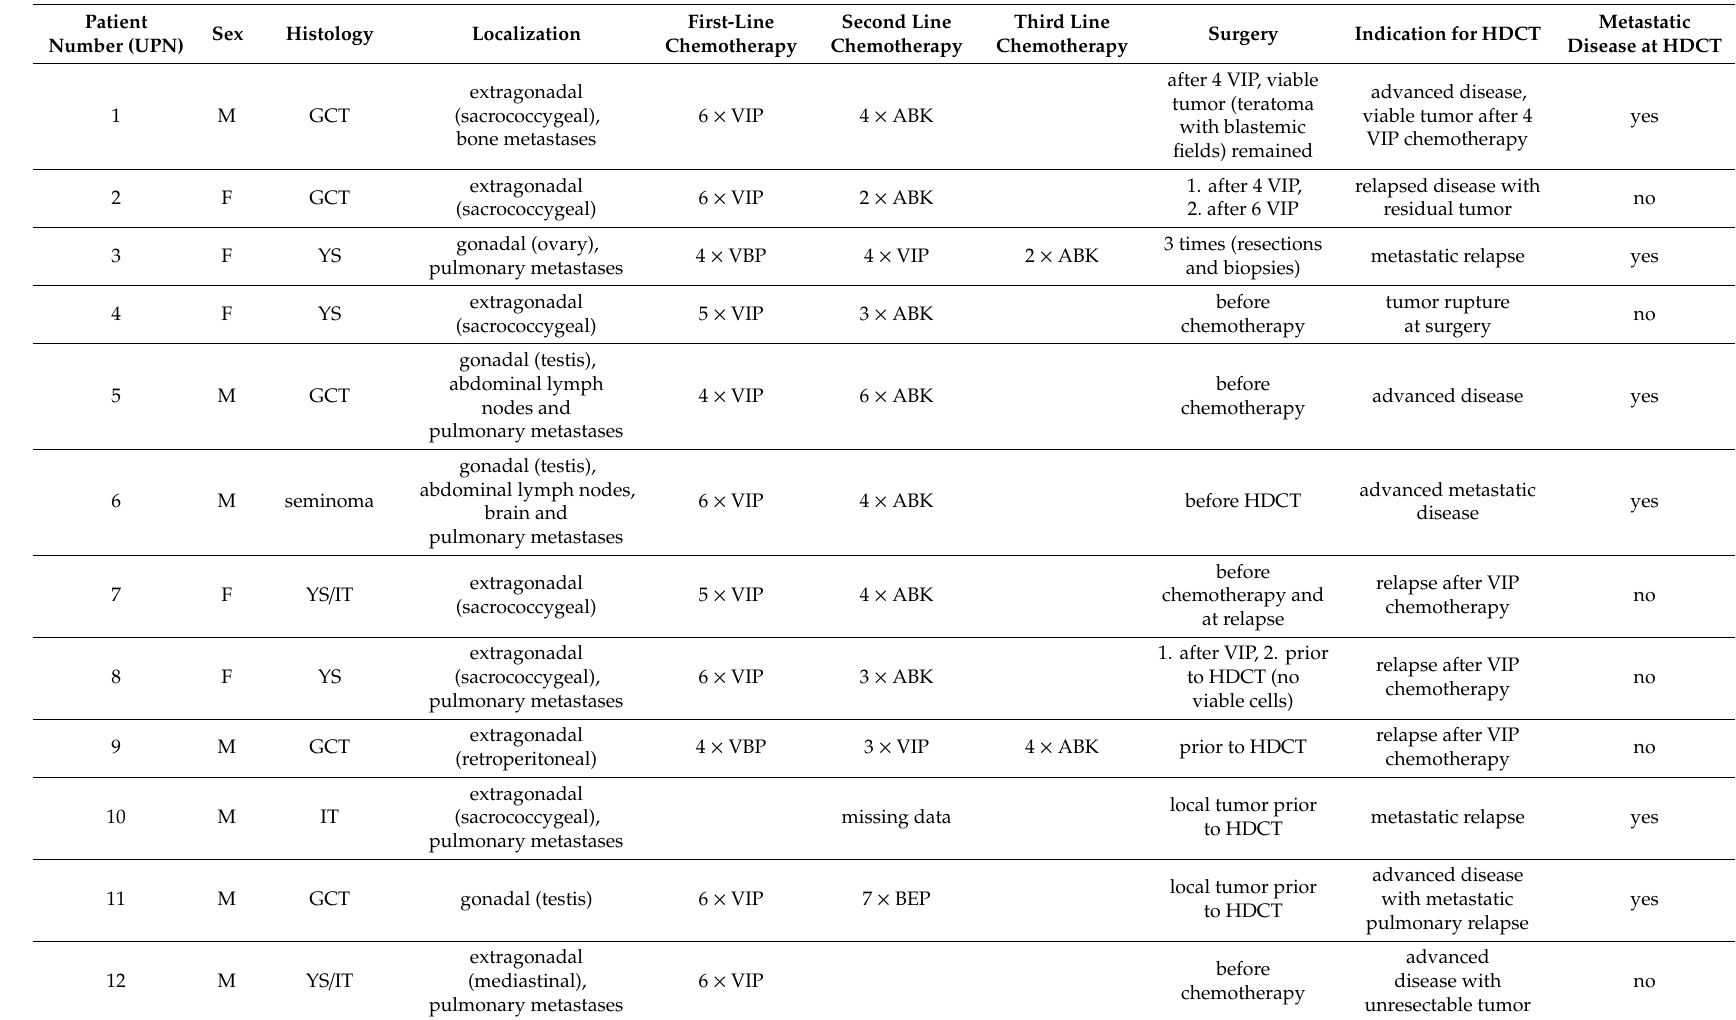
Table 1. Summary of demographics and baseline patient